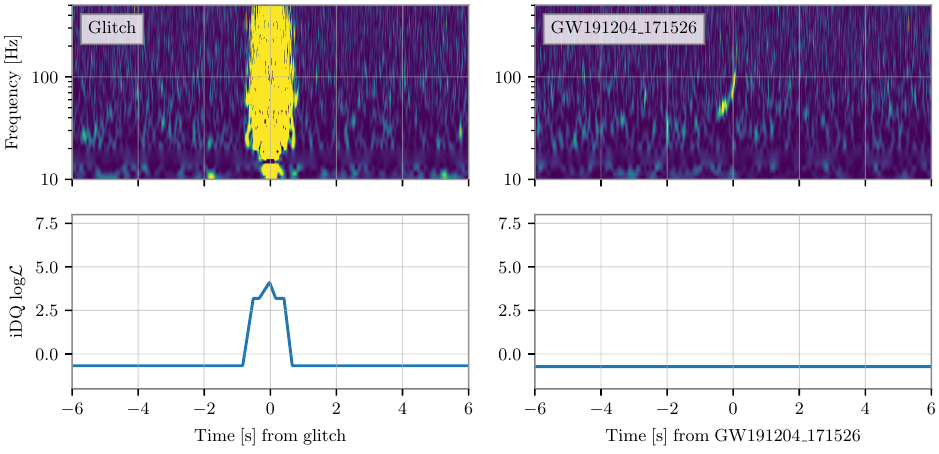
Figure 6. A comparison of the iDQ log-likelihood time series near a glitch and a gravitational-wave signal. Top row: Spectrograms of the LIGO Livingston strain data around a glitch and a gravitational- wave signal (GW191204_171526). Bottom row: iDQ log-likelihood time series for the same two time periods. In the case of the glitch, the iDQ time series is highly elevated at the time of the glitch, while in the case of the gravitational-wave signal no change in the time series is observed. The strain data are from GWOSC [90] while the iDQ data are from